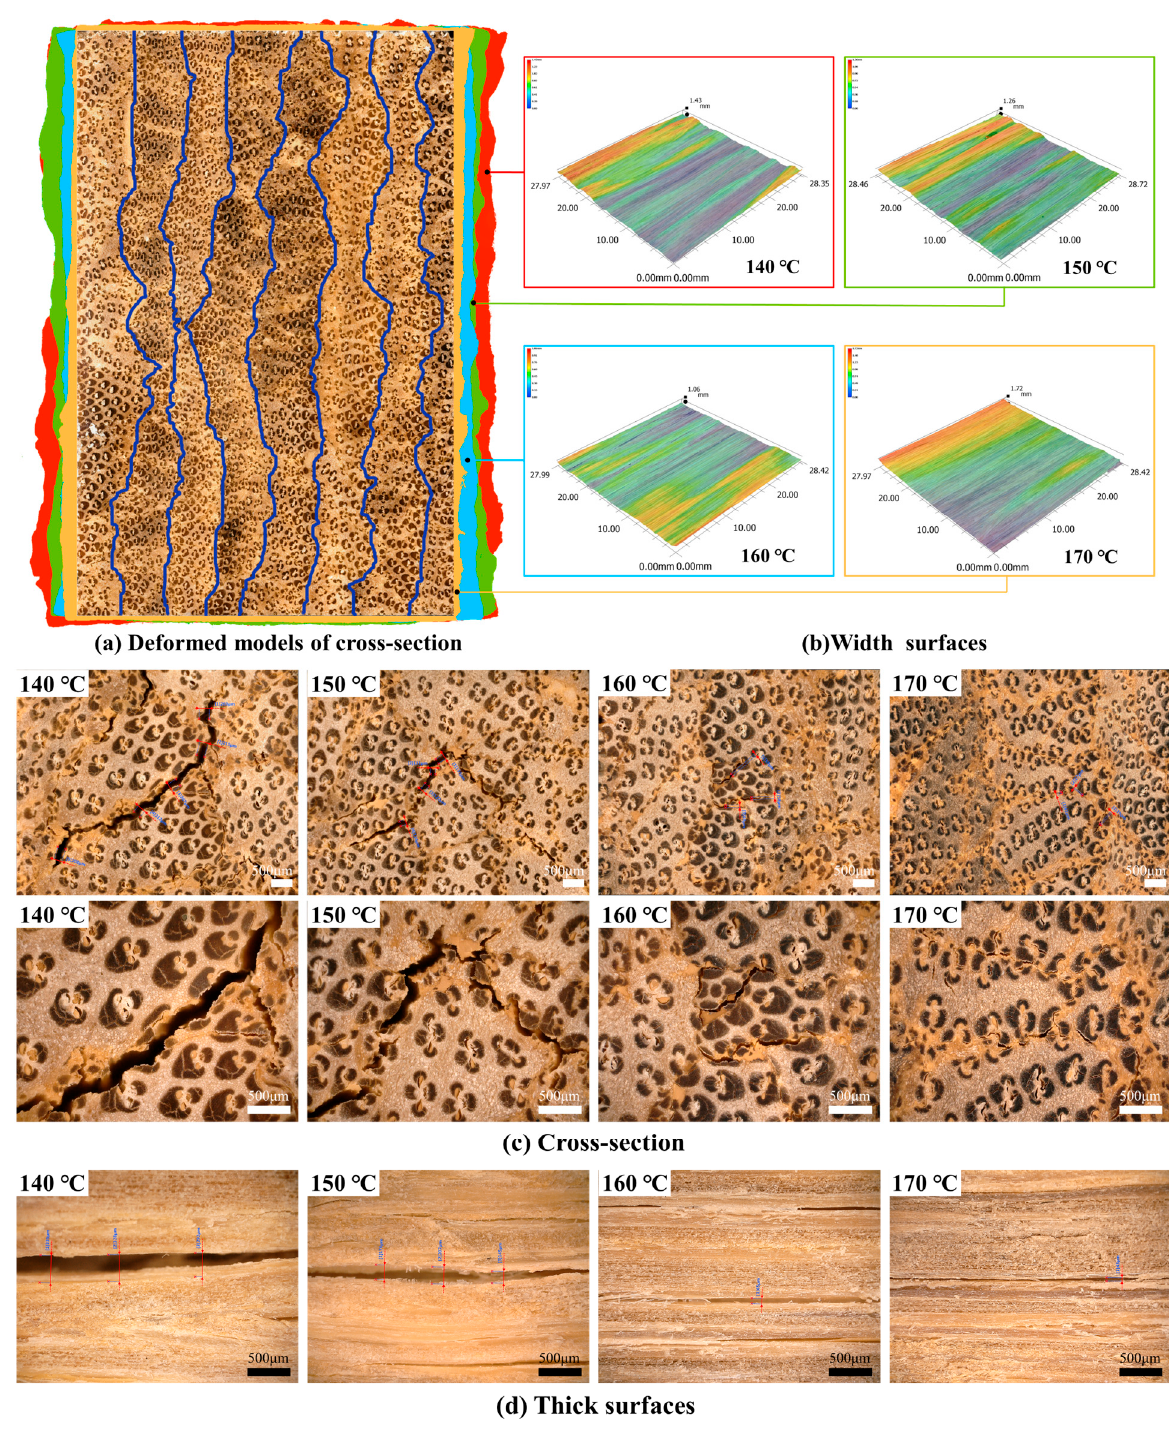
Figure 3. Surfaces of three dimensions: ( a ) deformed models of the cross-section, ( b ) width surfaces of bamboo scrimber with hot-pressing temperatures from 140 °C to 170 °C after 28 h cycle test, and typical cracks of ( c ) cross-sections and ( d ) thick surfaces of bamboo scrimber samples with various hot-pressing temperatures after a 28 h cycle test.